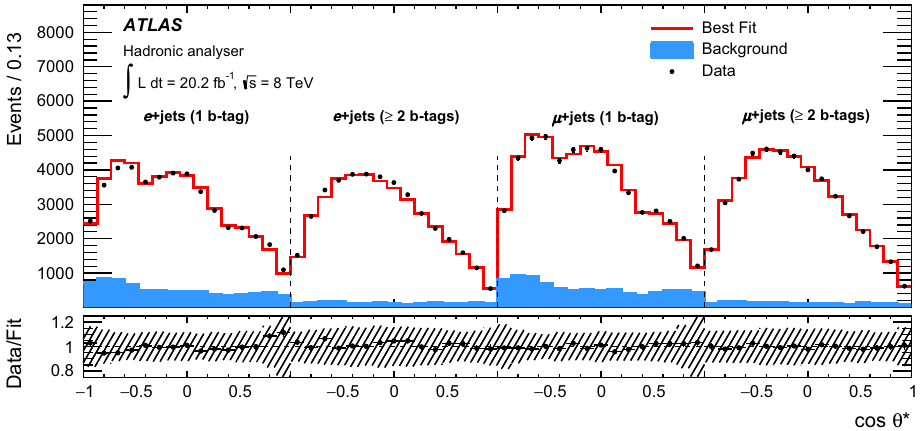
Fig. 5 Post-fit distribution of cos θ ∗ for the hadronic analyser, in which the combination of four channels is performed (electron and muon, with exactly 1 b -tag and ≥ 2 b -tags). The uncertainty band represents the total uncertainty in the fit